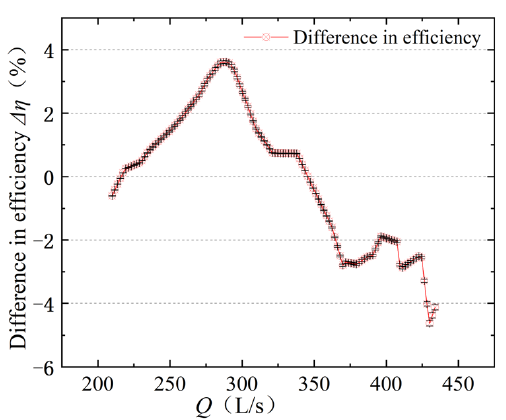
Figure 6. Efficiency analysis graph.